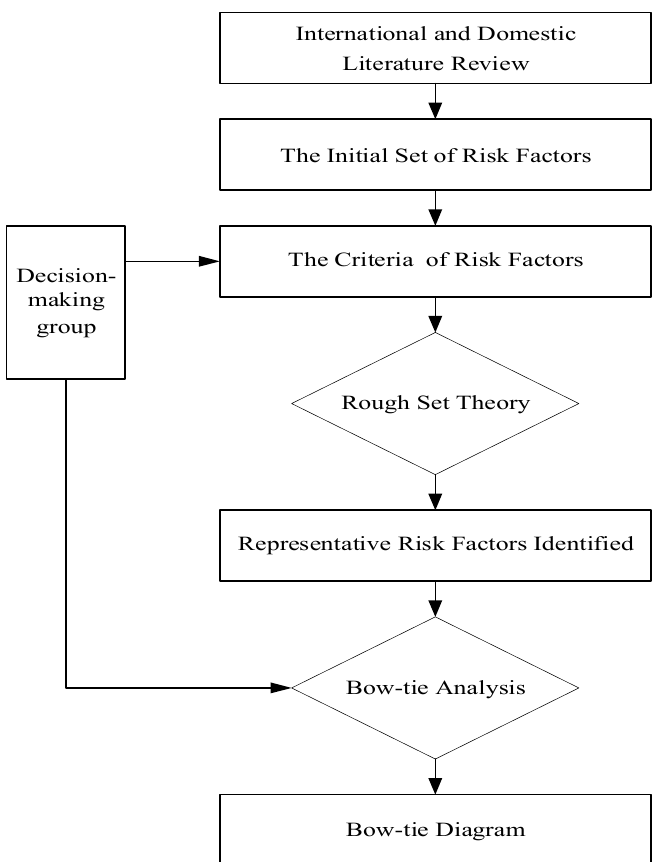
Figure 1. Flow diagram of the research.